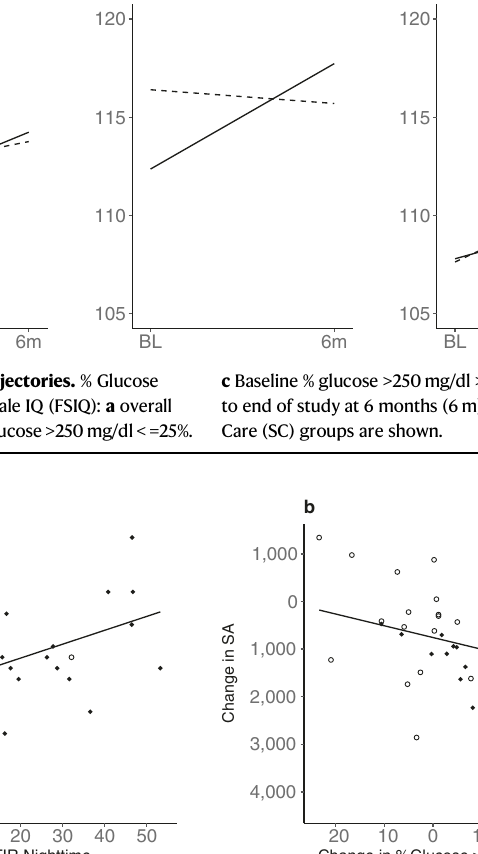
Fig. 6 | Correlation between change in glucose sensor values and change in cognitiveandimagingmetricsovertime. Associationofchangefrombaselineto 6 months in ( a ) Perceptual Reasoning Index (PRI) with % time in range (TIR)